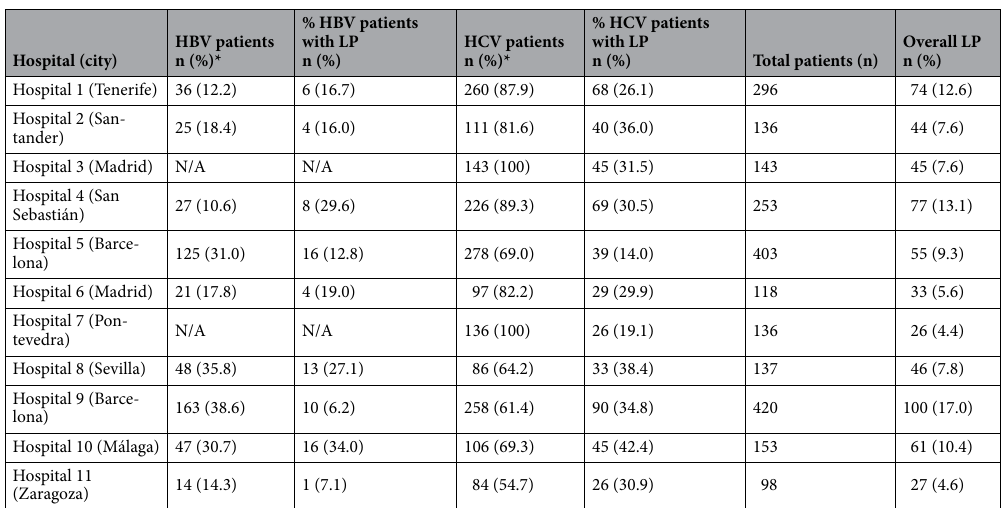
Table 5. Proportion of HBV and HCV LP patients categorised by 11 participating Spanish centres, 2018/2019. N/A not available—did not provide HBV data. HBV hepatitis B virus, HCV hepatitis C virus, LP late presentation. *(%) reported in relation to the total of all patients in the